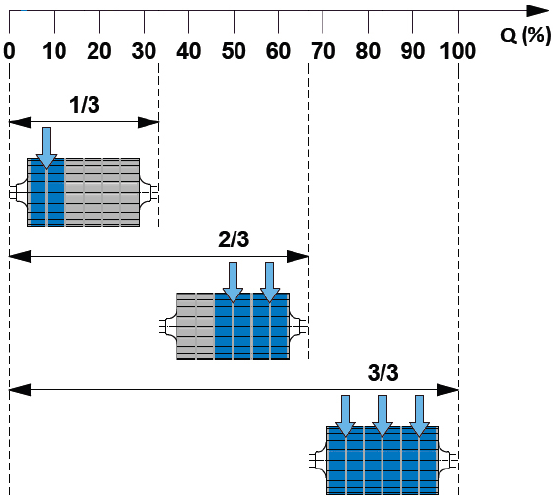
Figure 6. Cross-flow turbine: compartments and flexible